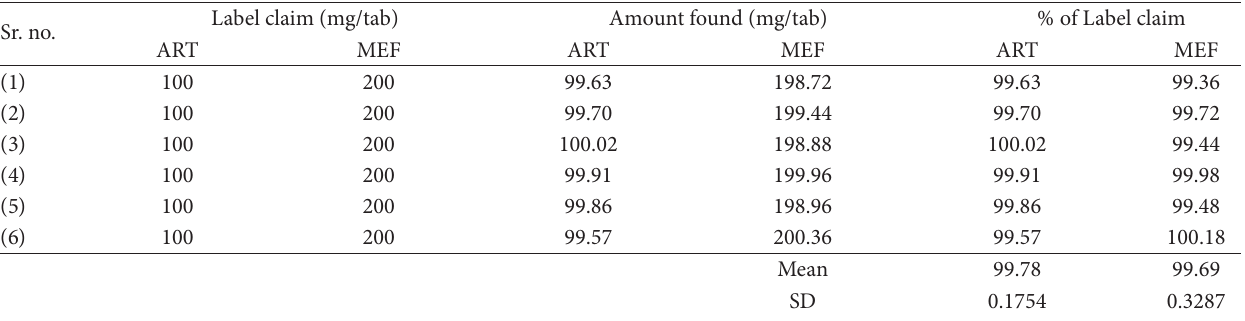
T 5: Results of marketed tablet formulation.